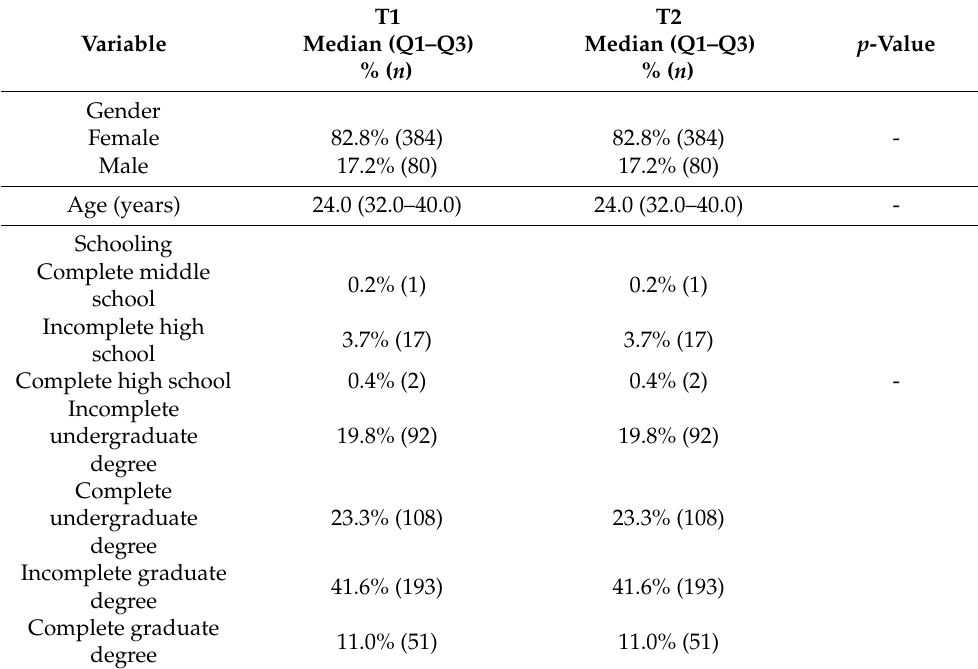
Table 1. General characteristics of the volunteers who participated in the first and second phases of the